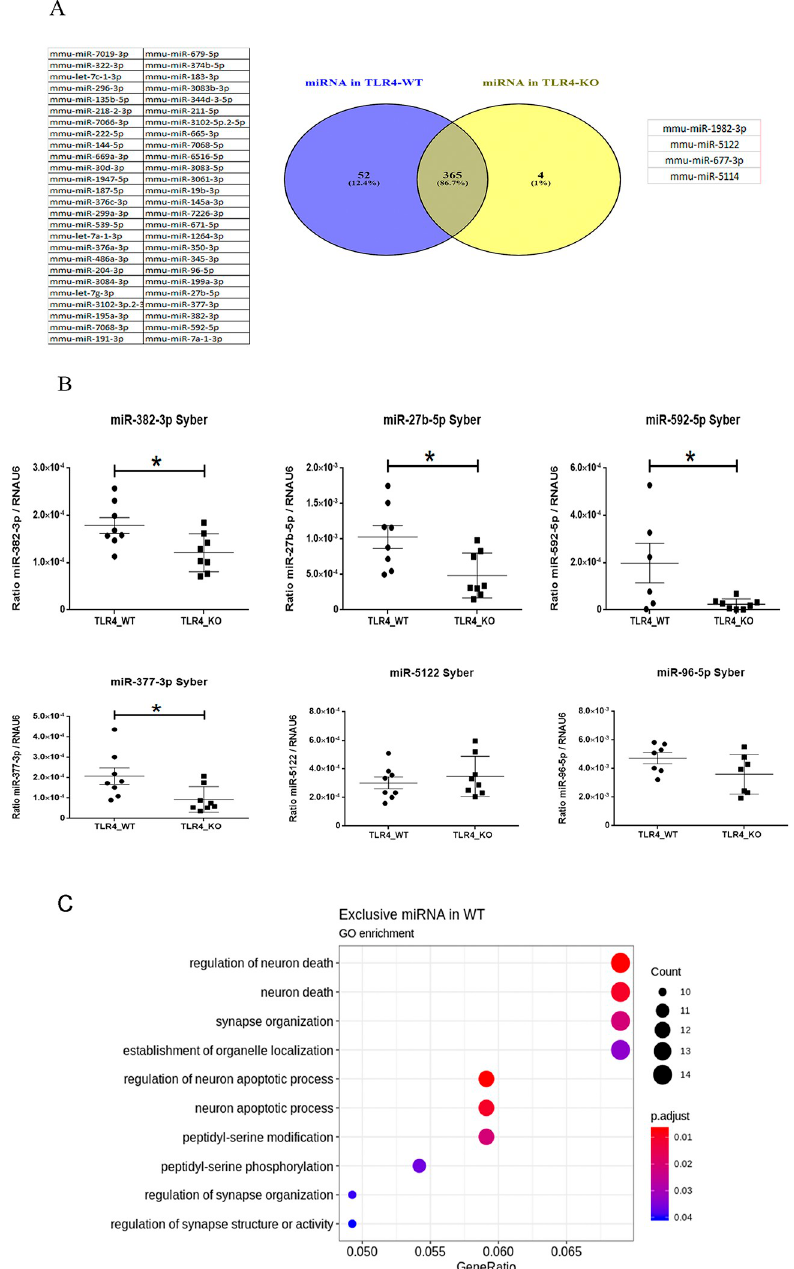
Fig 3. Unique miRNA profile for each genotype: ( A ) The Venn’s diagram illustrated that 365 miRNAs were commonly expressed in both genotypes; 52 miRNAs were exclusively expressed for the WT and only four miRNAs belonged to the TLR4-KO mice. ( B ) RT-qPCR confirmed the differential expression pattern of some miRNAs, e.g. miR-382-3p, miR-27b-5p, miR-592-5p and miR-377-3p, which were down-regulated in the TLR4-KO mice, while miR-96-5p and miR-5122 were not deregulated as predicted by NGS. A statistical analysis was performed by the t-test with n = 6–8. Statistical significance with a p-value of � < 0.05 and �� < 0.01. ( C ) Bioinformatics enrichment analysis of specific miRNAs in the WT